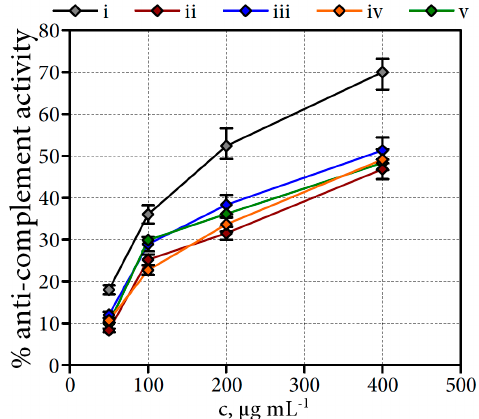
Figure 4. Anti-complement activity of crude water-soluble polysaccharide fractions (WSPS) from